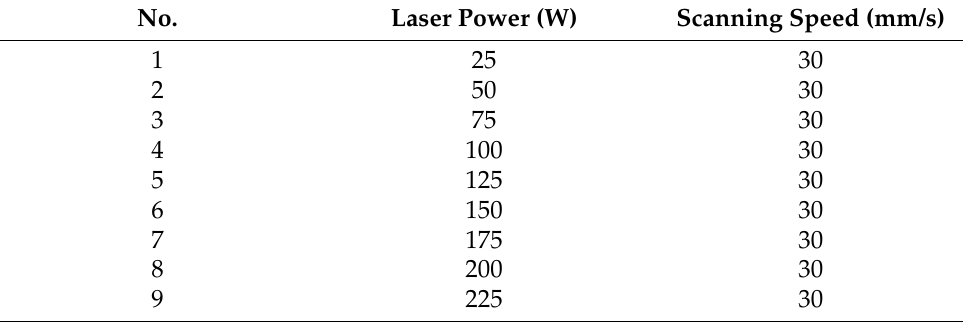
Table 3. Parameters of laser power and scanning speed.